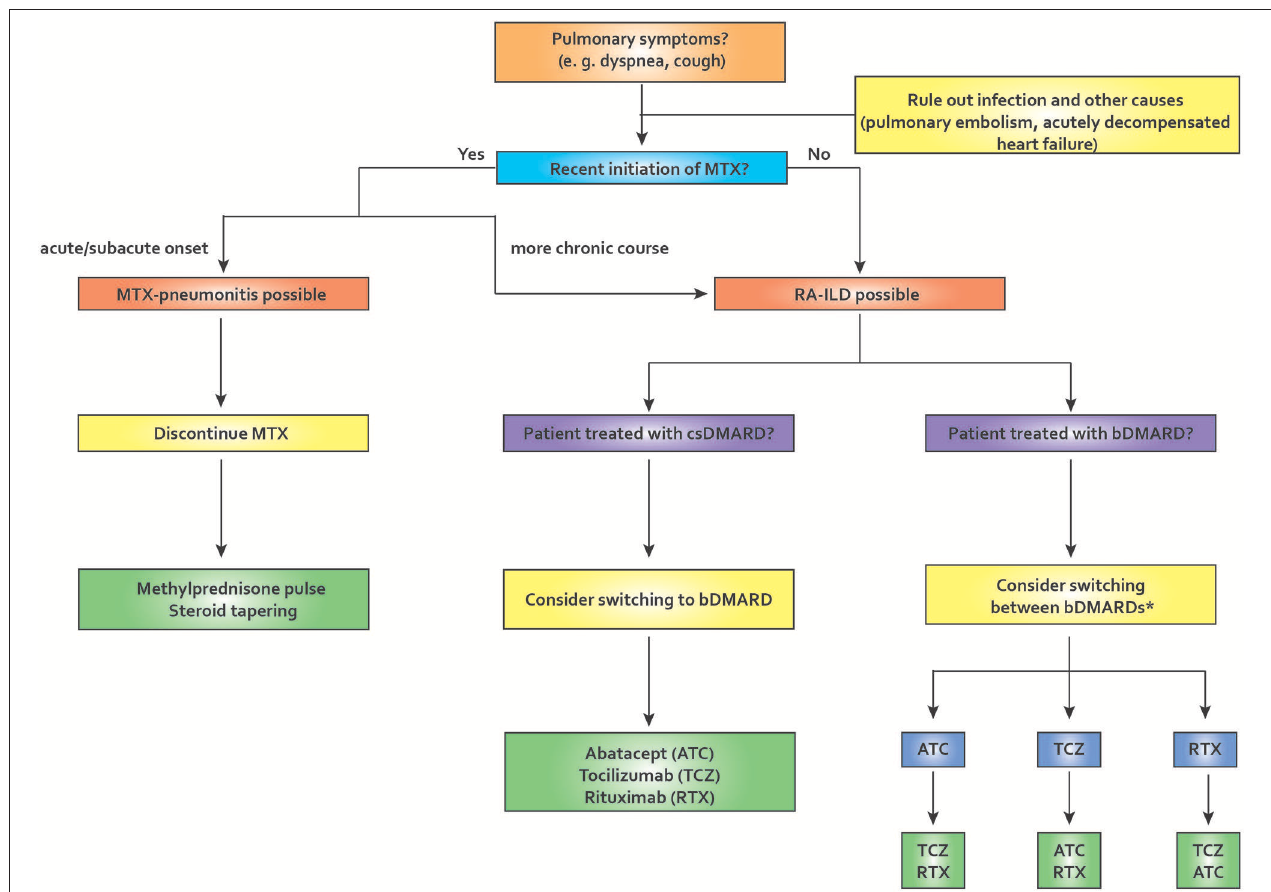
FIGURE 3 | Proposed algorithm for pulmonary symptoms in rheumatoid arthritis. In the setting of recent MTX initiation, MTX-pneu is always a concern, especially if the onset of symptoms is acute or sub-acute. In this case, MTX needs to be stopped and usually glucocorticoid therapy and supportive care in an intensive care unit is required. If the onset is more insidious, RA-ILD is a possibility. After ruling out other causes of pulmonary symptoms, management should depend on various factors, including comorbities, age, disease activity, and others. If a patient is diagnosed as having RA-ILD and receives a csDMARD, switching to a bDMARD may be appropriate. If a patient is already on bDMARD therapy, switching therapies may be required. Many authors tend to avoid TNF-inhibitors in this situation, but the evidence is weak. ATC, abatacept; bDMARD, biological disease-modifying antirheumatic drug; csDMARD, conventional synthetic disease-modifying antirheumatic drug; ILD, interstitial lung disease; MTX, methotrexate; MTX-pneu, MTX-pneumonitis; RA, rheumatoid arthritis; RTX, rituximab; TCZ, tocilizumab. *TNF-inhibitors have been reported to be associated with worsening lung function in RA-ILD (weak evidence